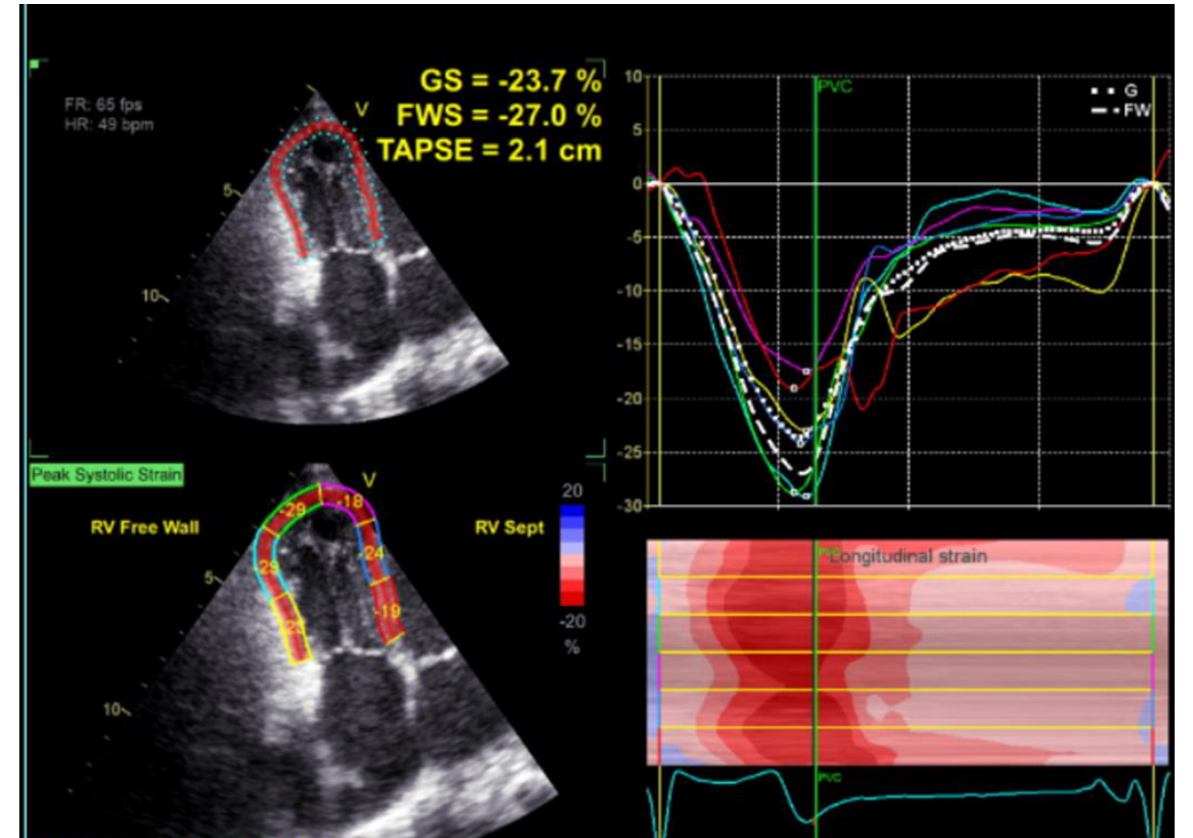
Figure 7. Normal stain of the right ventricle ten years later.